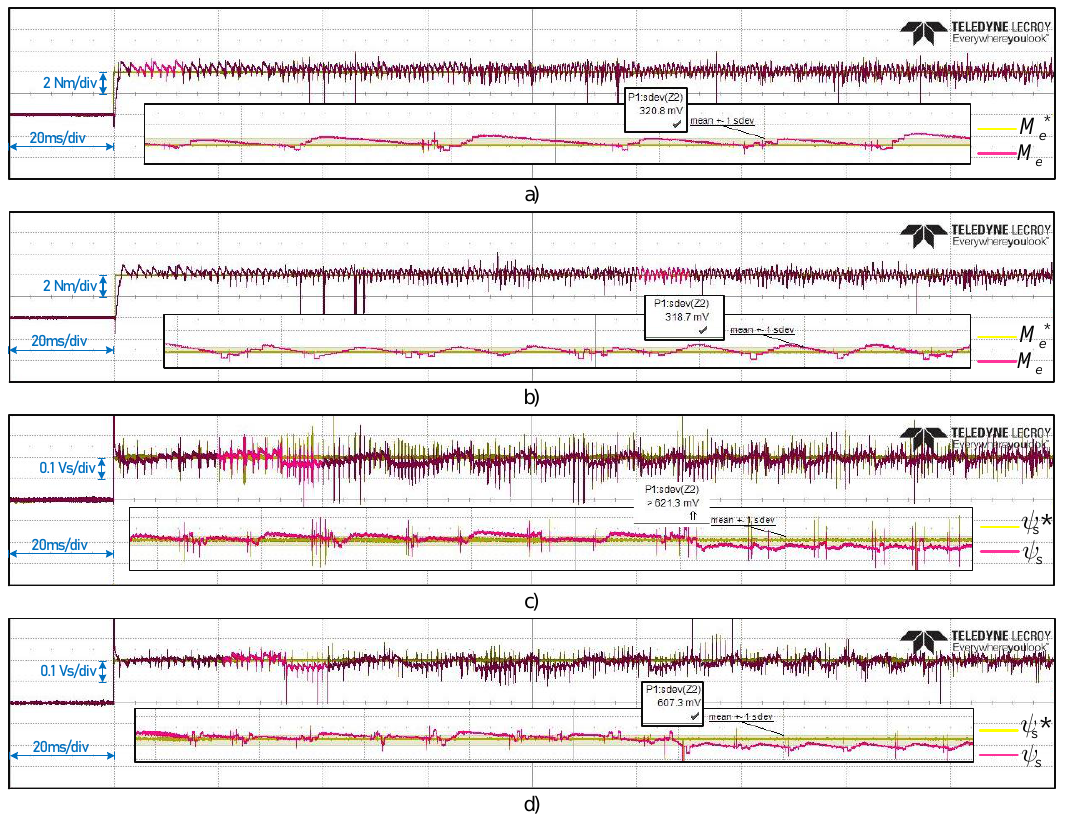
Figure 9. Experimental results under parameter variation of 80% from nominal parameters. ( a ) Electromagnetic torque conventional deadbeat control. ( b ) Stator flux conventional deadbeat control. ( c ) Electromagnetic torque proposed deadbeat control. ( d ) Stator flux proposed deadbeat